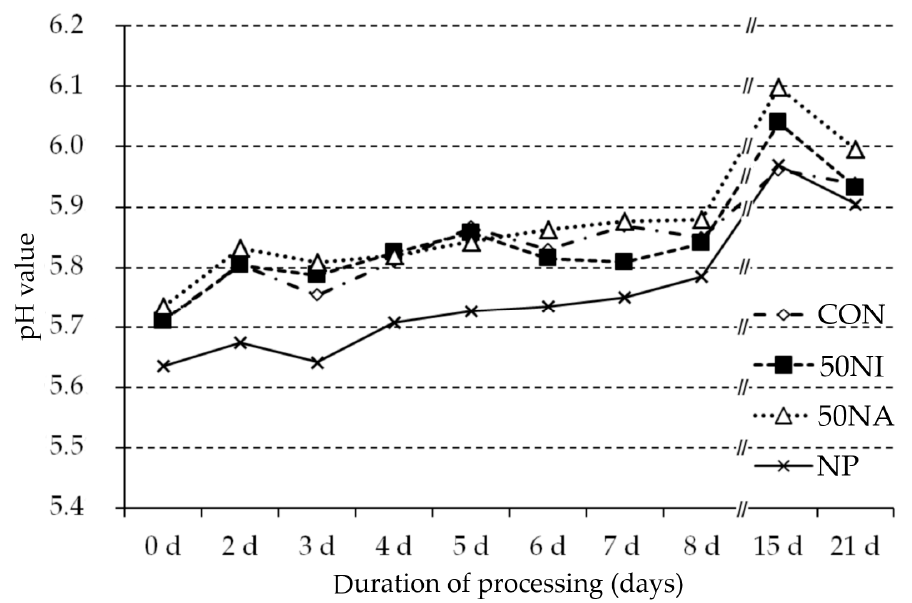
Figure 2. Changes in pH during the sausage processing according to formulation (CON = control with 110 mg/kg sodium nitrite and 0.2% phosphates; 50NI = 50% less sodium nitrite than in control; 50NA = 50% less sodium nitrite than in control with added 225 mg/kg sodium ascorbate; NP = no phosphates and 110 mg/kg sodium nitrite).